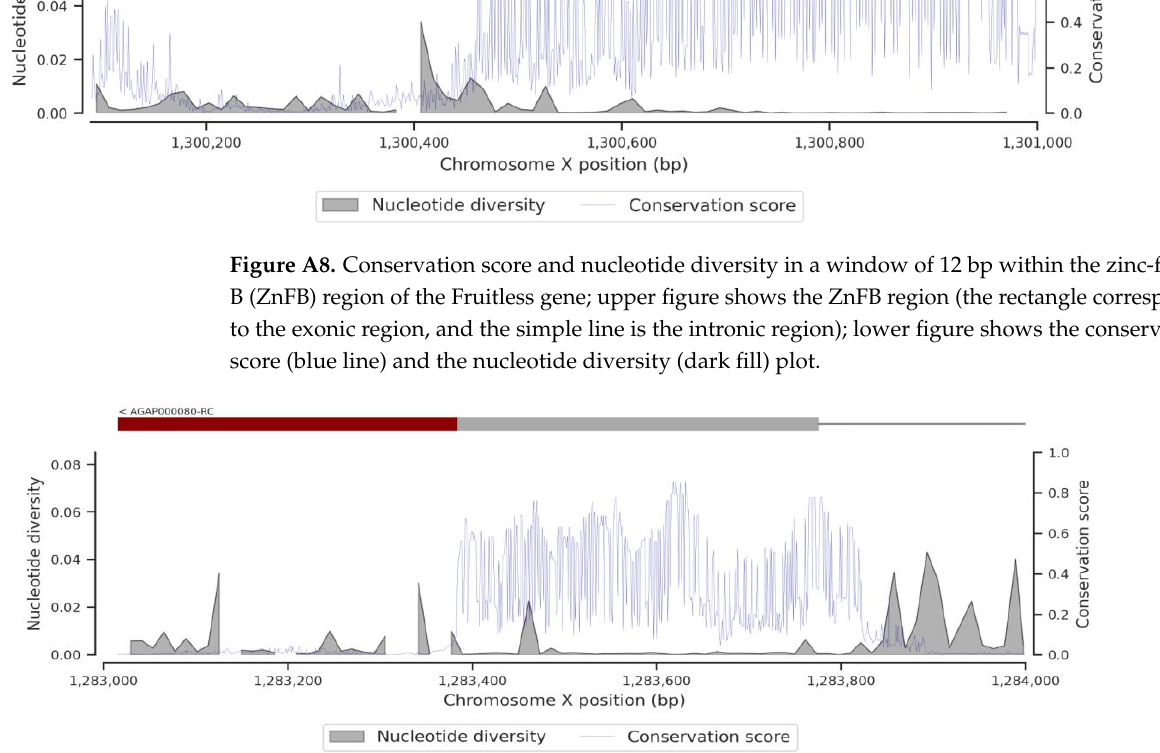
Figure A10. Conservation score and nucleotide diversity in a window of 12 bp within the Cyp9k1 (X:15240572-15242864), a gene shown to be under selection pressure [36]; upper figure shows the genomic region of the Cyp9k1 (the rectangle corresponds to the exonic region, the dark red ends are the 3′ and 5′ UTR regions, and the simple line is the intronic region); lower figure shows the conser- vation score (blue line) and the nucleotide diversity (dark fill) plot. The conservation score remains high in the exonic regions compared to the intronic ones, as it is found in the fru gene. References 1.